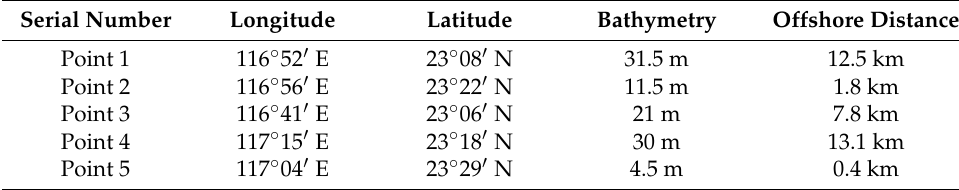
Figure 10. Water level line and flow field map of typhoon transit compared with normal wind field conditions. Table 5. Information of typhoon monitoring